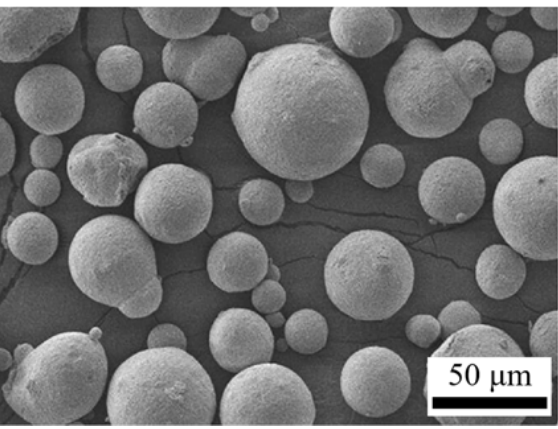
Figure 1. Surface morphology of spray granulation powders.